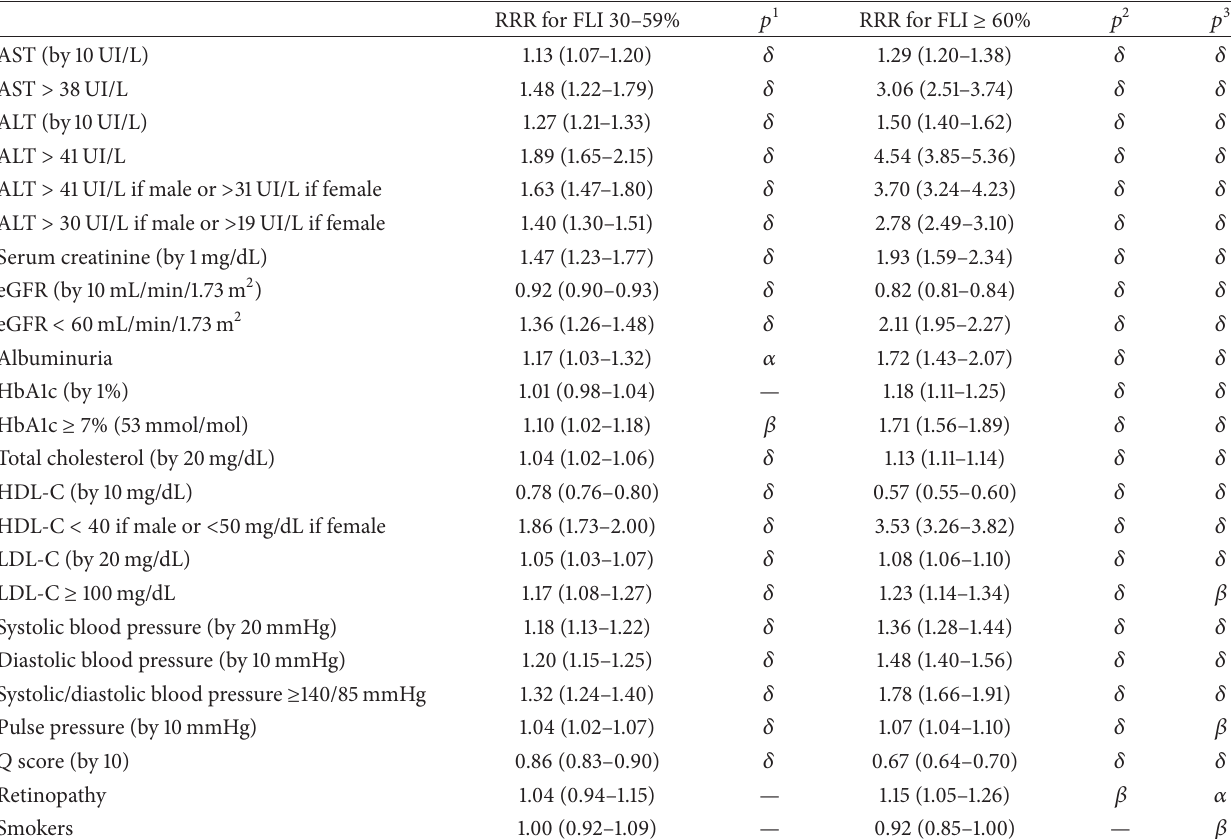
Table 2: Relative risk ratios adjusted for gender, age, and duration of